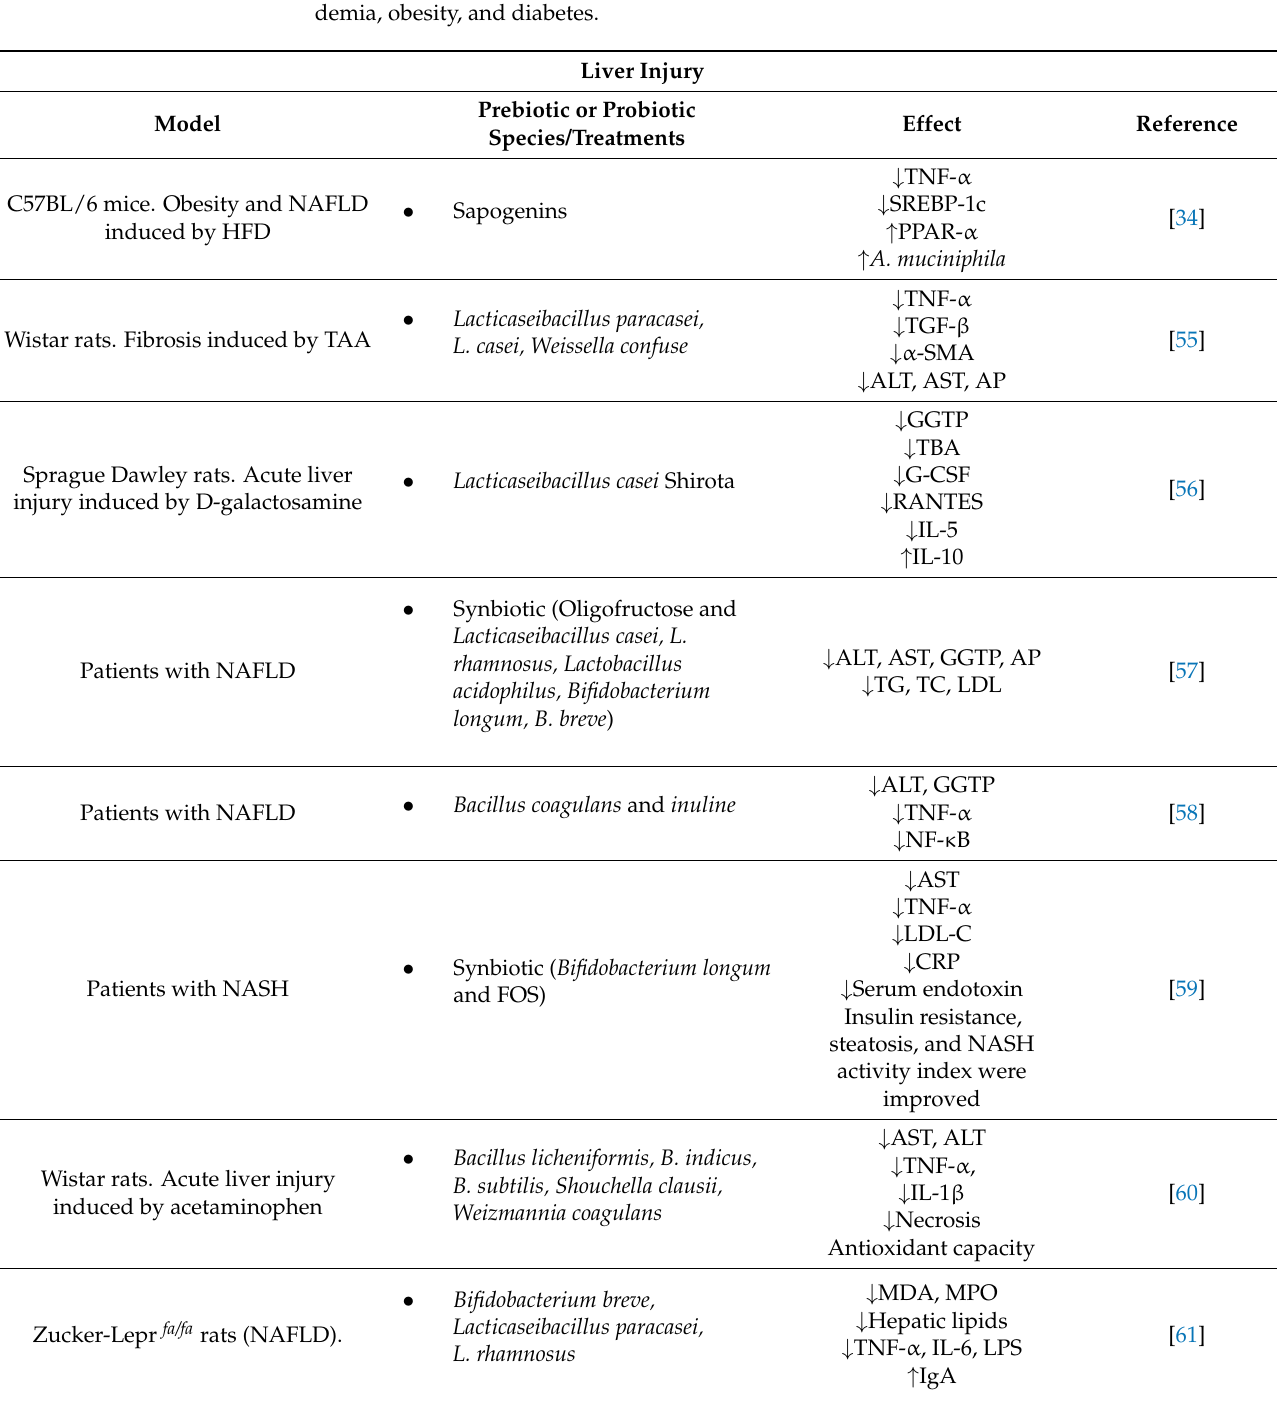
Table 1. Effects of prebiotics, probiotics, and synbiotics in liver disease, colitis, gastritis, hyperlipi- demia, obesity, and